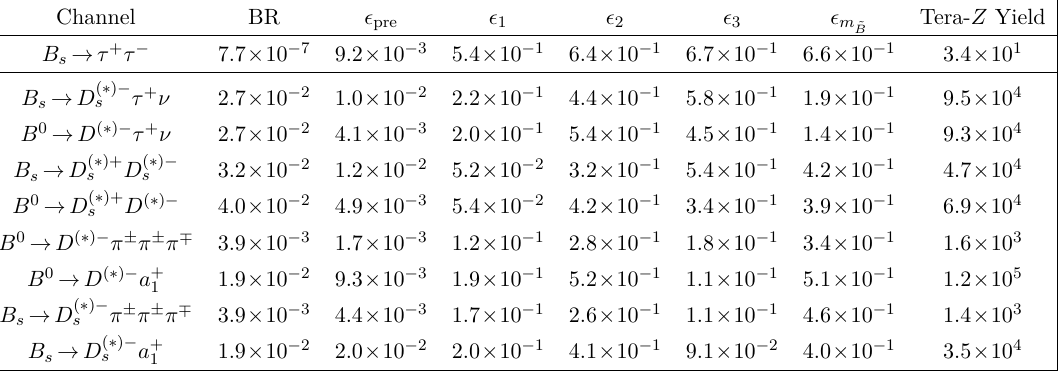
Table 14 . Detailed cut flows and Tera- Z yields for the B s → τ + τ − measurement. (cid:15) denotes the efficiency for each cut defined in the